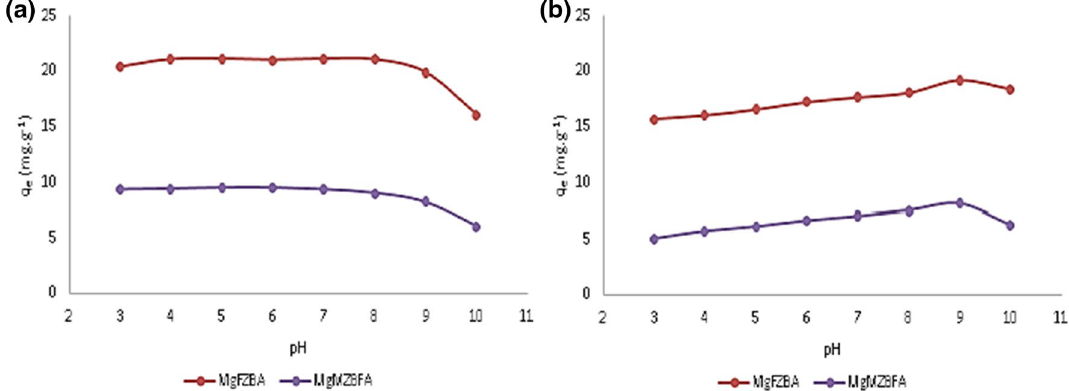
Fig. 11 Effect of pH on the sorption of a PNAN, b NB on MgFZBFA and